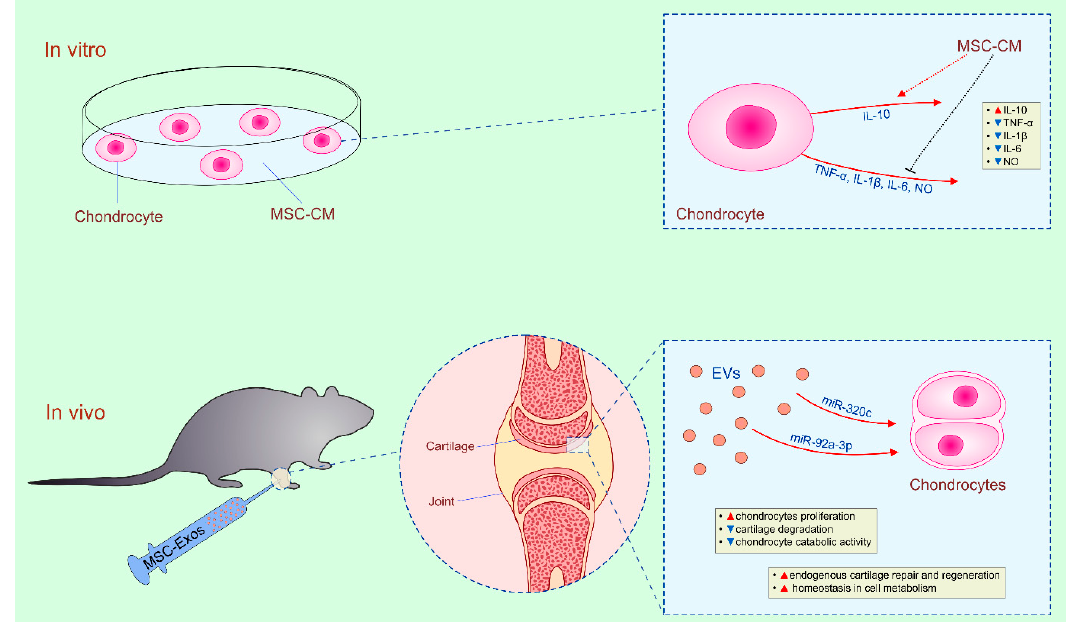
Figure 2. herapeutic effects of MSC-derived secretome in cartilage regeneration. Chondrocytes cultured in the presence of MSC-derived secretome significantly reduce production of inflammatory cytokines which play detrimental role in cartilage degeneration during OA development (TNF- α , IL-1 β , IL-6, nitric oxide (NO)) and increase production of immunosuppressive IL-10 which protects cartilage from inflammation-related injury. Accelerated neotissue filling and increased synthesis of type II collagen were noticed in osteoarthritic animals that received MSC-sourced secretome. MSC-derived extracellular vesicles (EVs) promoted endogenous cartilage repair and regeneration by delivering miR-320c and miR-92a-3p which restore homeostasis in bioenergetics and cell metabolism in proliferating chondrocytes.